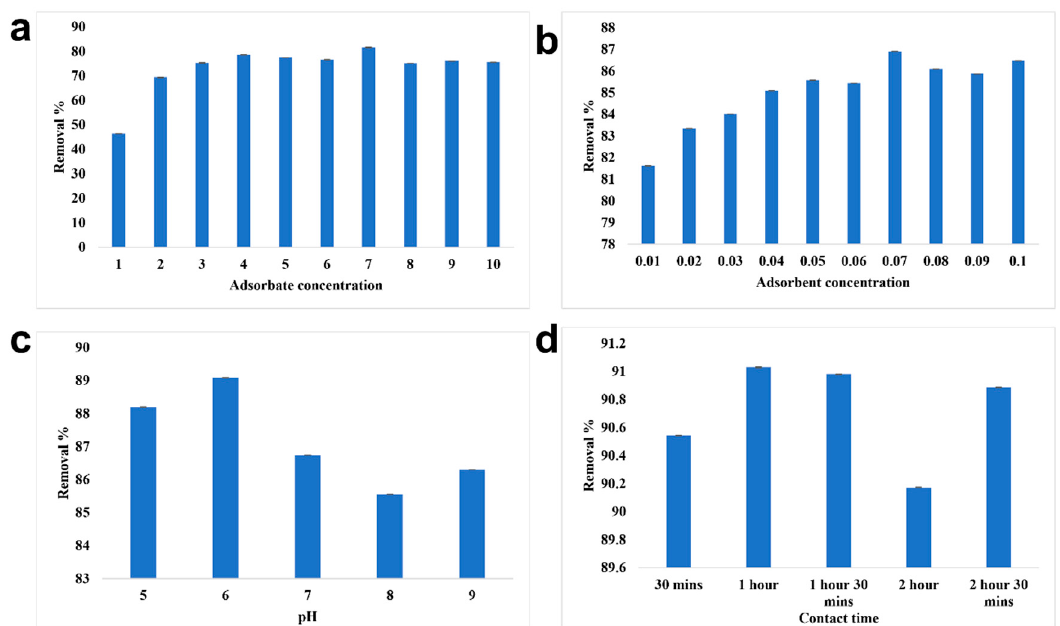
Figure 8. Batch adsorption study of alginate beads. ( a ) Optimization of adsorbate concentration, ( b ) Optimization of adsorbent concentration, ( c ) Optimization of pH, ( d ) Optimization of contact time.